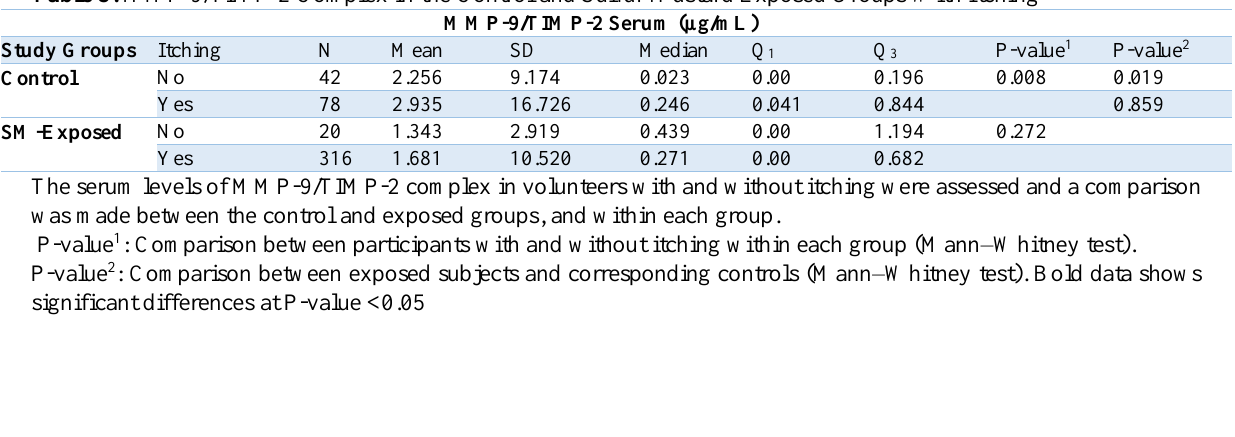
Table 3. MMP-9/TIMP-2 Complex in the Control and Sulfur Mustard Exposed Groups With